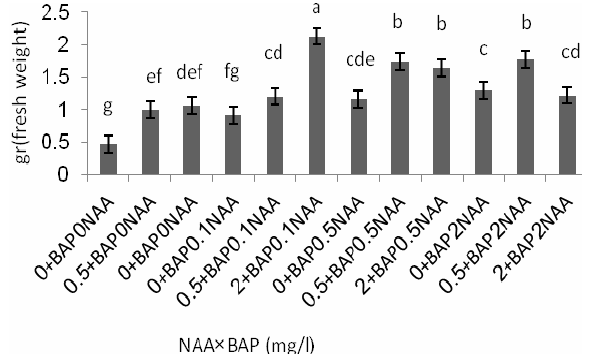
Fig. 8. The effect of interaction of NAA and BAP on fresh weight of callus; Duncan’s multiple range test at 0.1%